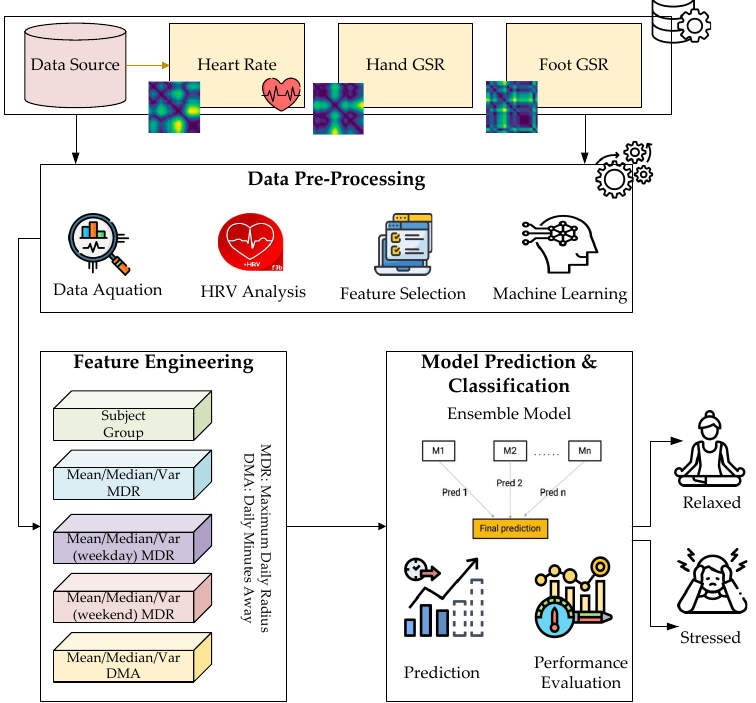
Figure 1. Overview of the proposed